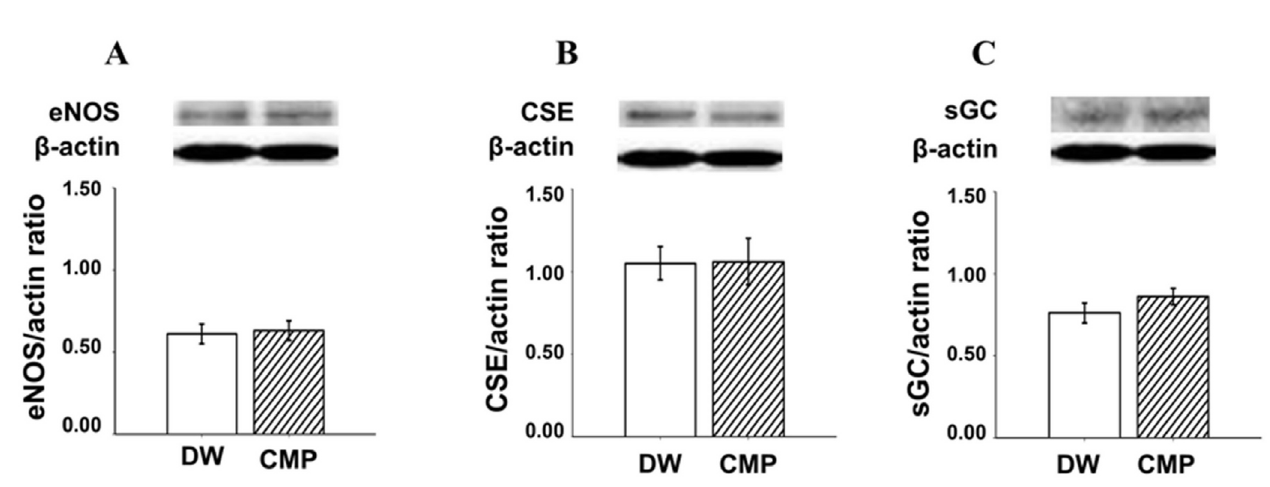
FIGURE 8 - Effects of CMP (1 g/kg) or distilled water (DW, control) consumption by the middle-aged male rats on eNOS protein expression (A), CSE protein expression (B), or sGC protein expression (C) of the thoracic aorta. For each blot, β-actin expression is shown as a loading control. Values represent mean ± SEM; n =